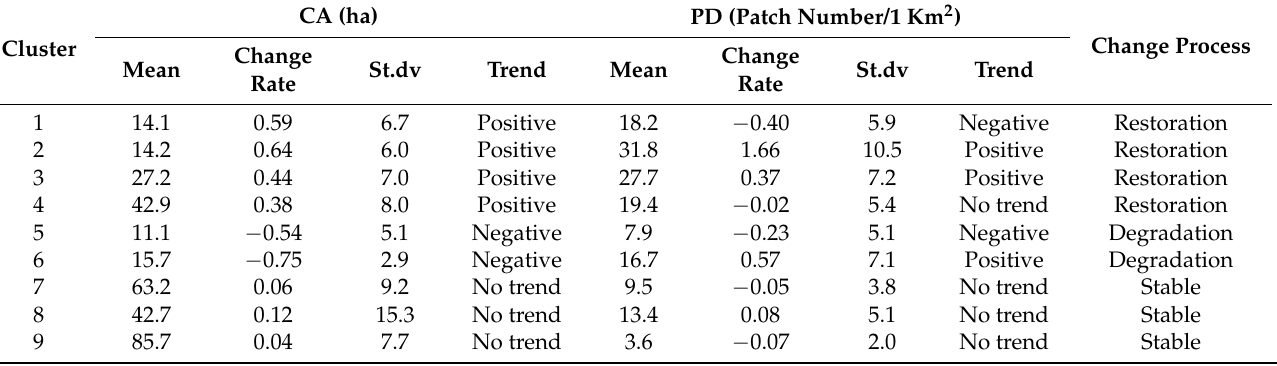
Table 5. Statistics of forest change